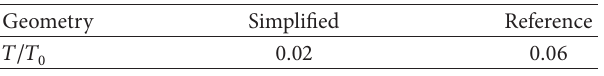
Table 3: Dimensionless windage torques relating to single-phase simulations.